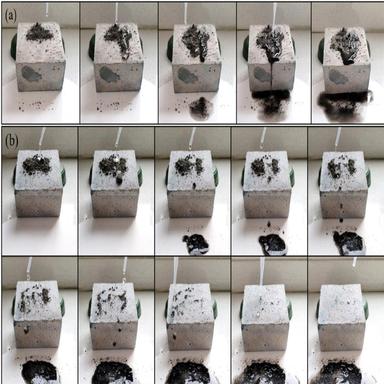
Self-cleaning test of two groups of the samples contaminated by fly ash powder. (a) Ordinary concrete samples and (b) superhydrophobic concrete samples.